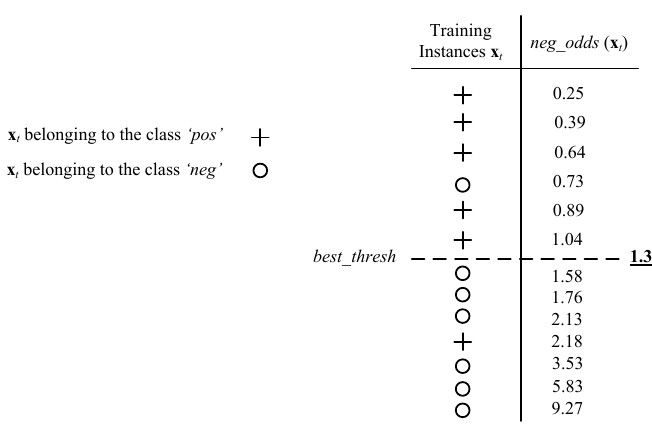
Figure 9. A data sample of the resulting thresholds on the Θ q , w ( . )